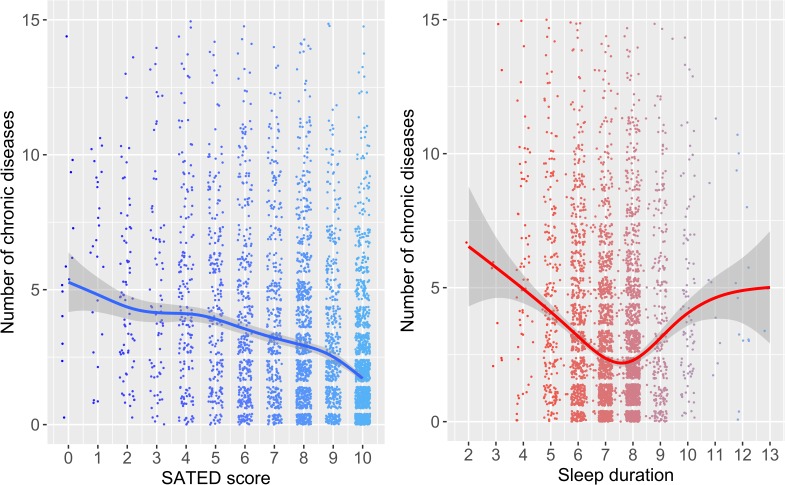
Associations of the SATED score and sleep duration with the number of reported chronic diseases.Non-parametric smoothed splines of the number of chronic diseases in relation to the SATED score and sleep duration. The gray areas correspond to 95% confidence intervals. Subjects with more than 15 reported chronic diseases are not shown but are considered in the models.